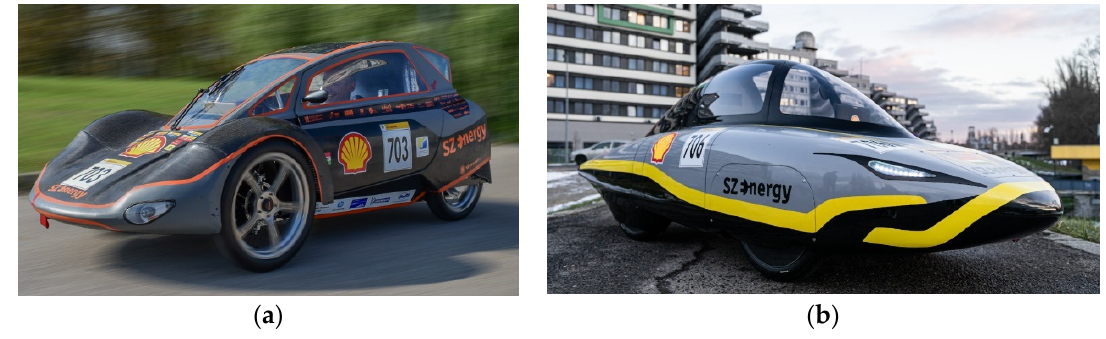
Figure 1. Investigated Urban Concept SEM vehicles: ( a ) SZElectricity; ( b )